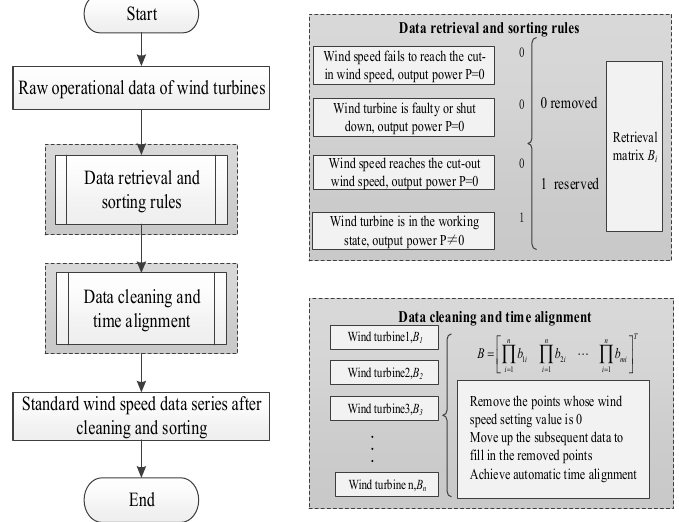
Figure 1. Flow diagram of wind speed operation data cleaning and sorting.